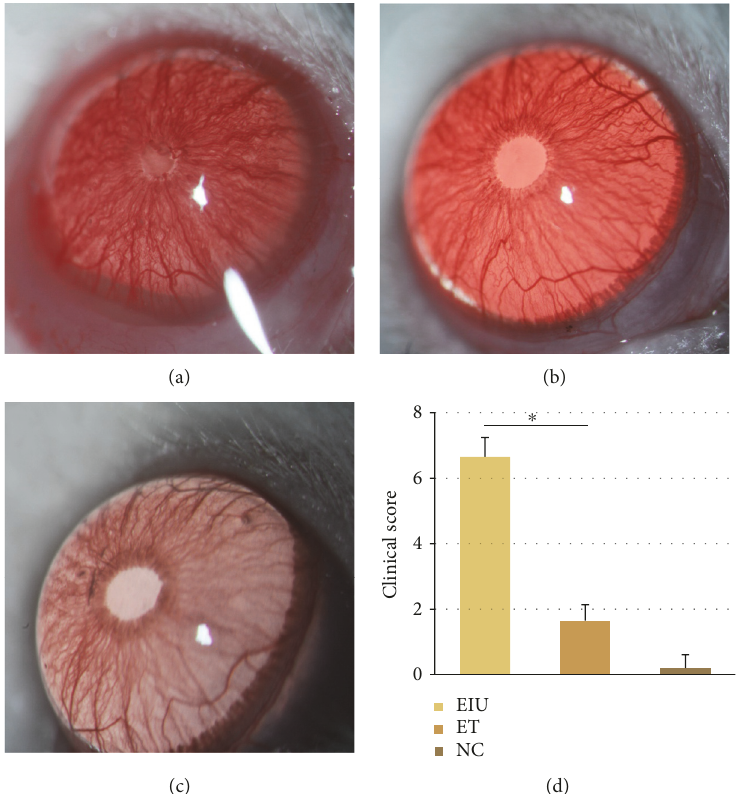
Figure 1: (a) Occlusion of pupil and fi brinous membrane was observed in the EIU group at 24 h after 200 μ g LPS injection. (b) Slight iris blood vessel dilatation could be found in the ET group at 24h after 200 μ g LPS injection. (c) No ocular in fl ammatory signs were observed in rats of the NC group. (d) All data shown as mean ± standard deviation ( n = 20 , eye). ∗ p < 0 05 signi fi cantly di ff erent from EIU